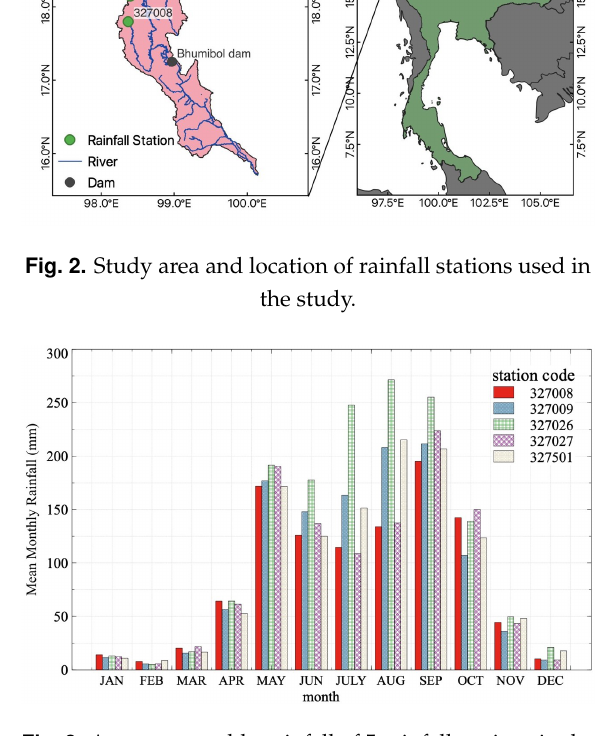
Fig. 3. Average monthly rainfall of 5 rainfall stations in the Ping river basin from 1975 to